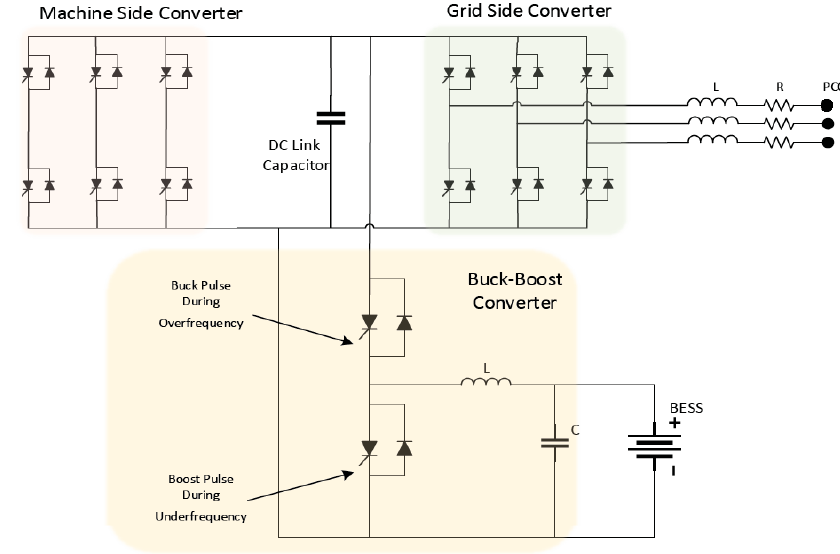
Figure 7. Circuit diagram of a VSP-based BPMS.